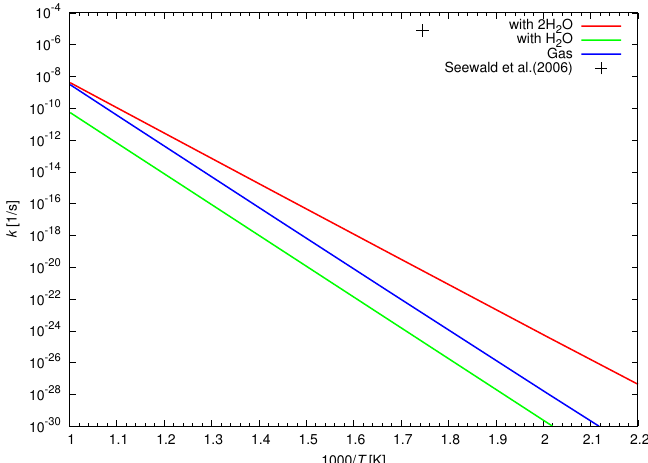
Figure 5. Rate constants for the reduction of methanol calculated in the present study as well as that determined by a laboratory experiment [44]. The rate constants were calculated when the reduction was catalyzed by up to two water